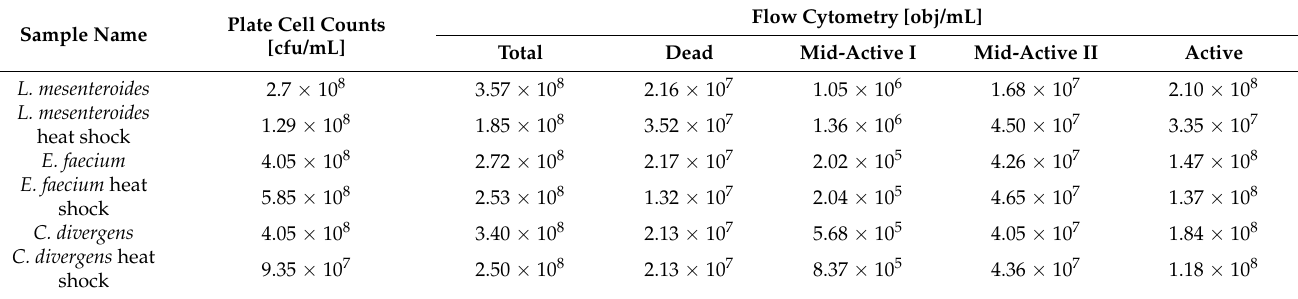
Table 1. Comparison of bacterial cell enumeration using plate cell counts and flow cytometric analysis.